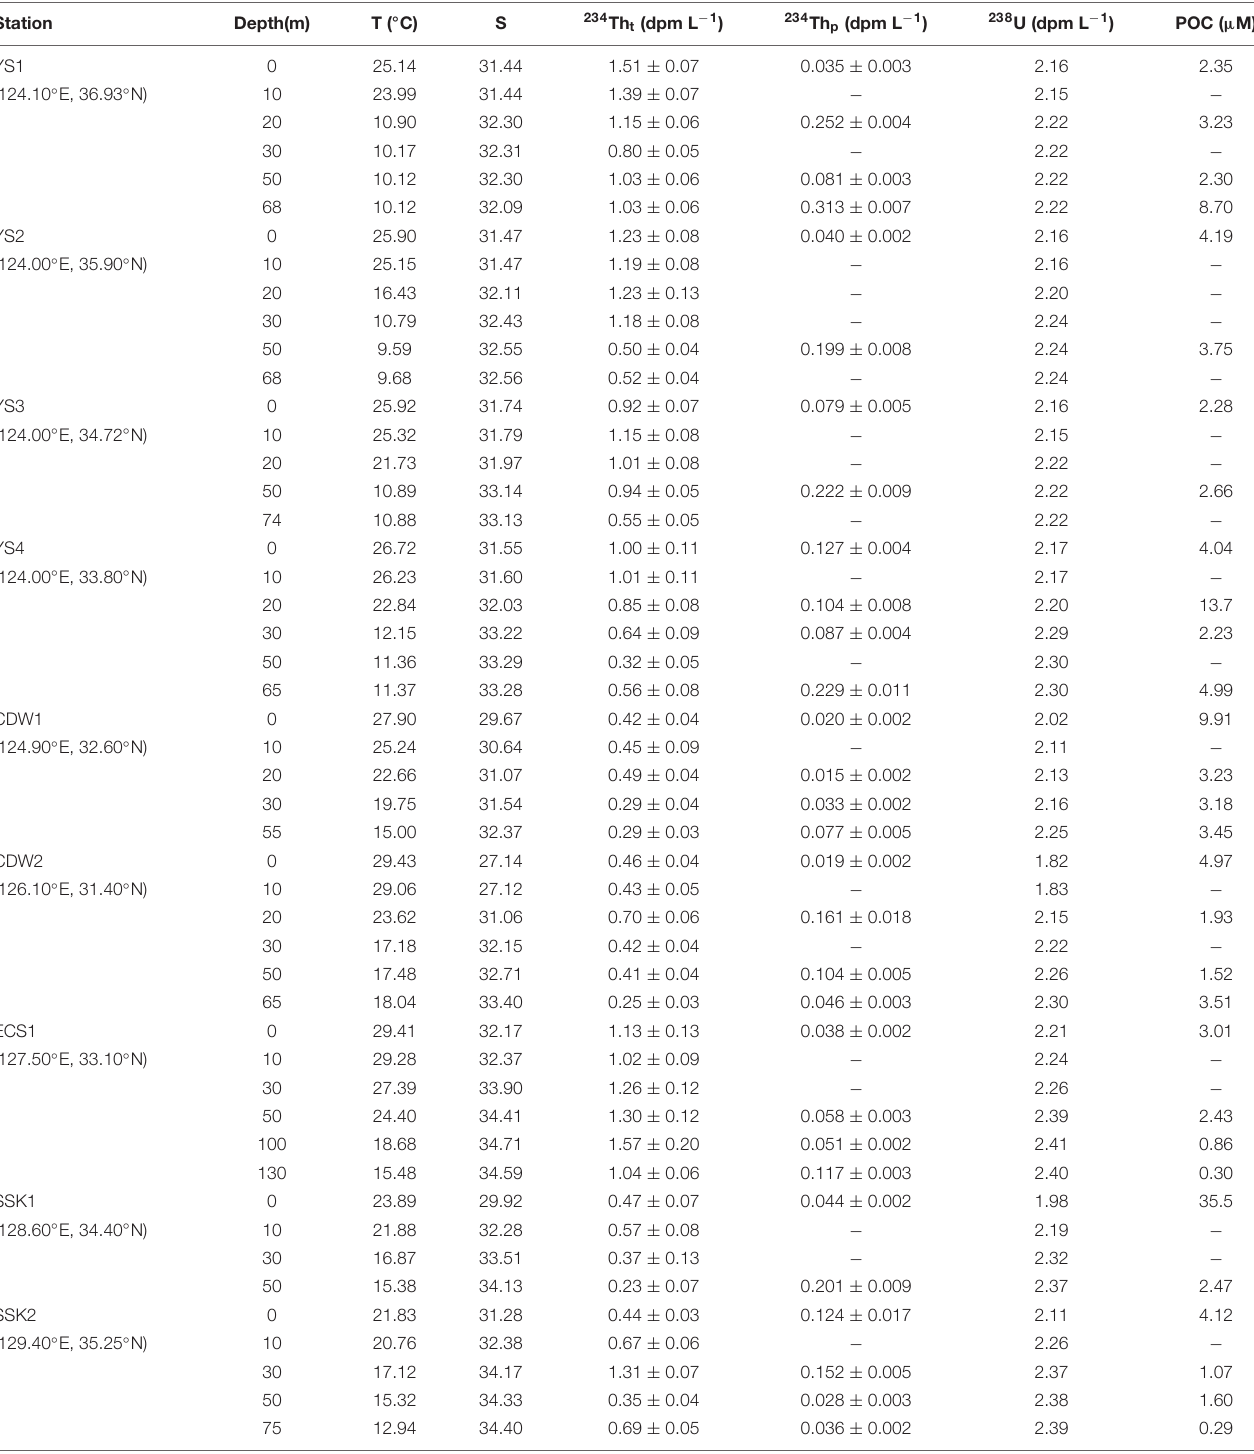
TABLE 1 | Temperature (T), salinity (S), 234 Th (total and particulate) and 238 U activities, and POC concentrations in the East China Sea and the Yellow Sea in August 2020.